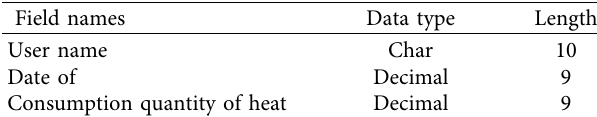
Table 3: Heat consumption meter.